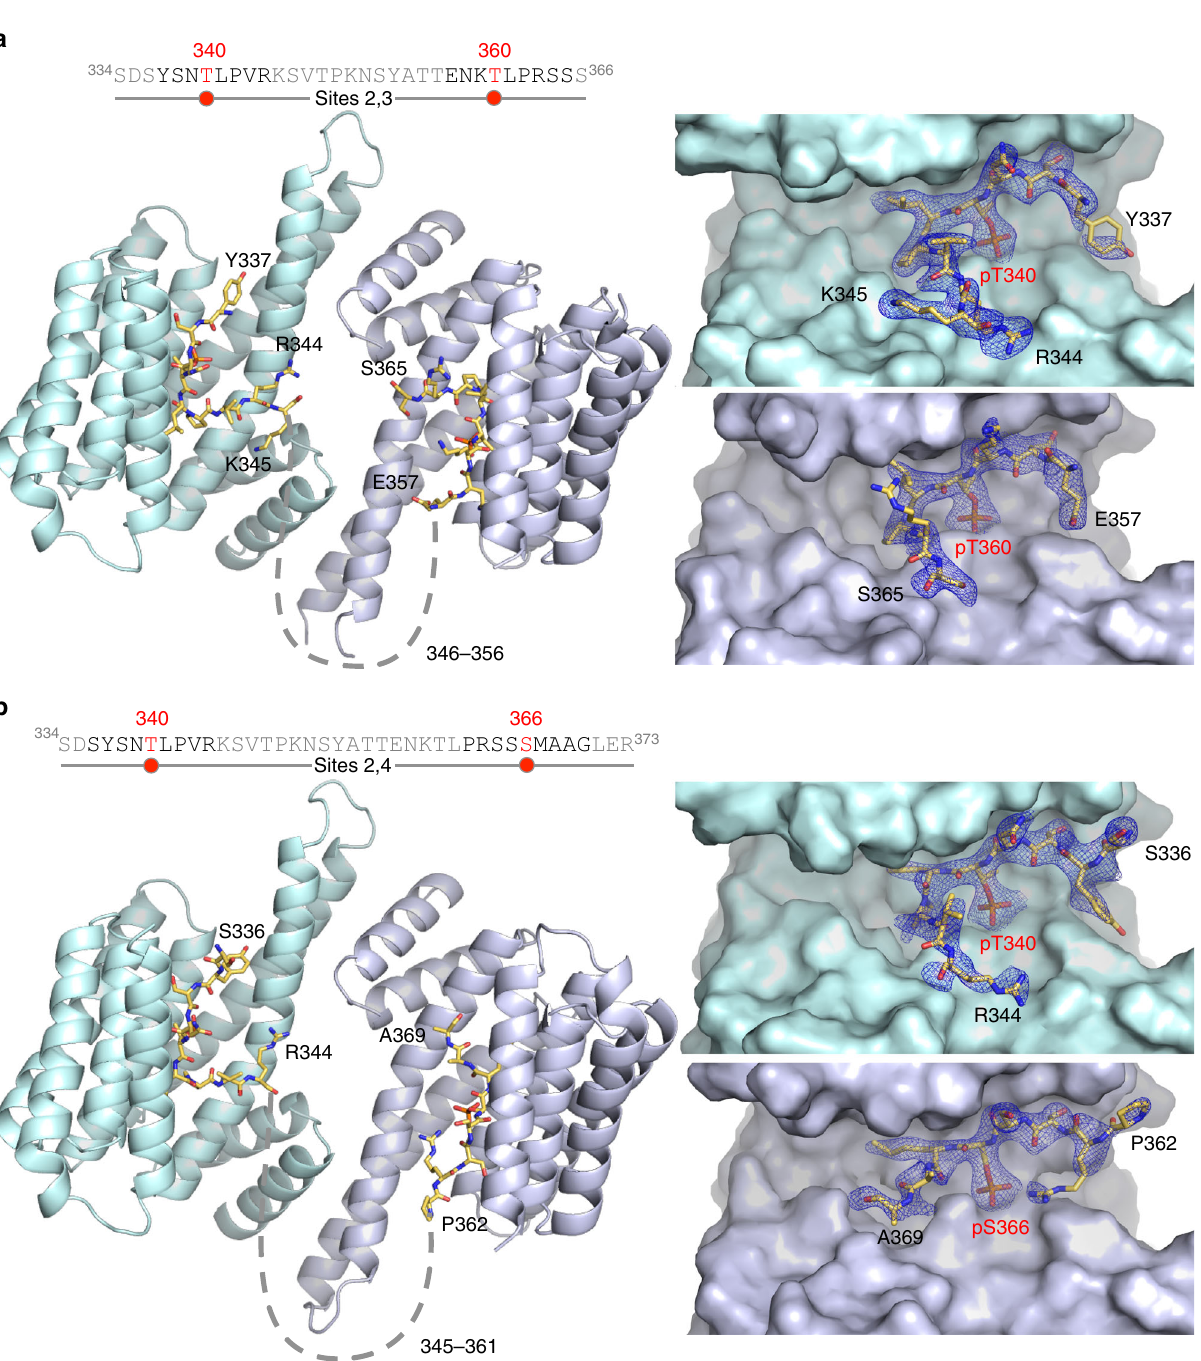
Fig. 4 Structures of complexes of 14-3-3 θ with doubly-phosphorylated IRSp53 peptides. a , b Complexes of 14-3-3 θ with the Sites 2,3 and Sites 2,4 peptides, showing the overall structure (left) and close-ups of the binding pockets of 14-3-3 θ and corresponding 2 F o – F c electron density maps contoured at 1 σ (right). In the sequence diagrams shown, the portions of the peptides observed in the structures are highlighted black and the phosphorylation sites are highlighted red, whereas unresolved amino acids are shown in gray. Dashed lines indicate the path between the observed portions of the bound peptides in the structures. Note that the sequences around the two phosphorylation sites of each peptide are different enough to be clearly distinguishable in the electron density maps in the separate pockets of 14-3-3 θ (see also Supplementary Figure 7), as con fi rmed by cross-comparisons with the structures of the corresponding singly-phosphorylated peptides (Supplementary Figures 5 and